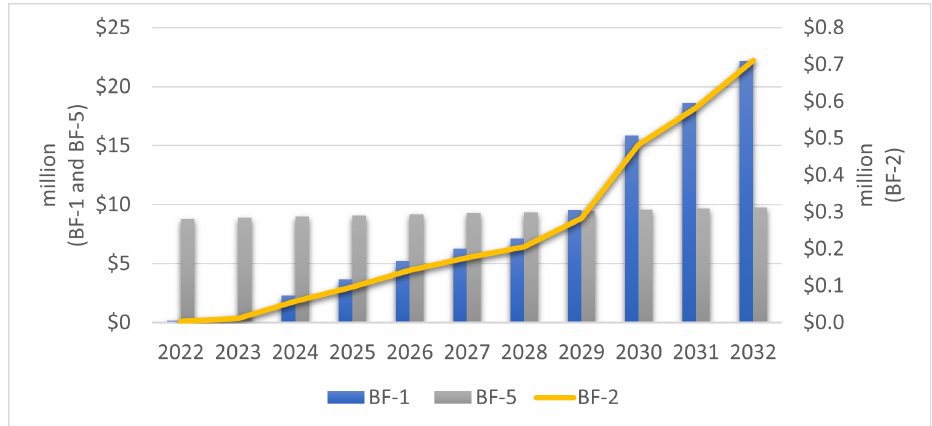
Figure 4. Yearly estimated values coming from BF-1 (see Section 4.1), BF-2 (see Section 4.2) and BF-5 (see Section 4.5).